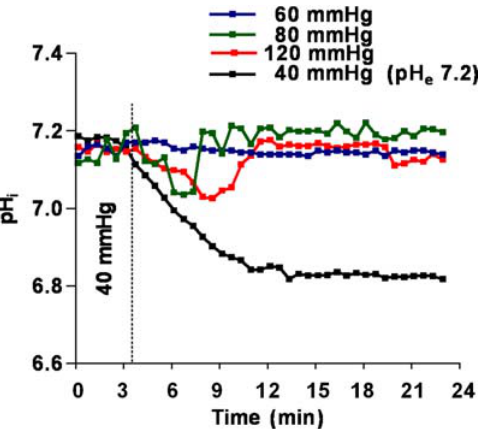
Figure 4. Effects of high CO 2 and extracellular acidosis on intracellular pH. Intracelluar pH (pH i ) was measured in real time as the change in fluorescence intensity of ATII cells loaded with BCECF/AM and exposed approximately 3 min to 40 mmHg, and then for the indicated time to 60, 80 and 120 mmHg CO 2 with pH e : 7.4, or 40 mmHg with pH e : 7.2. pH e : extracellular